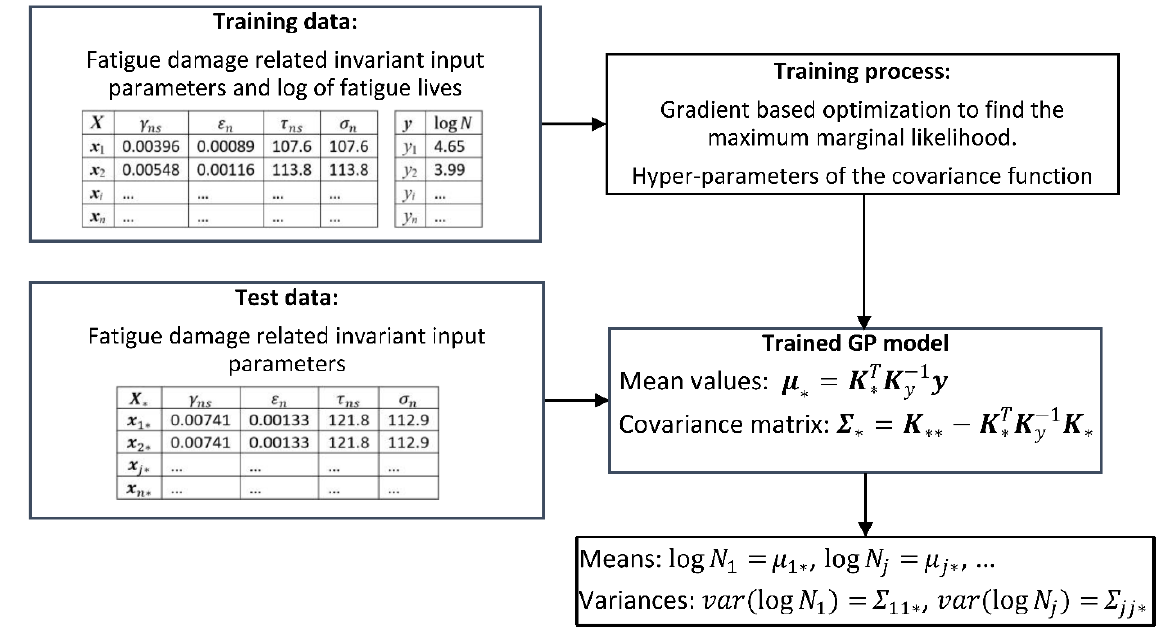
Figure A1. Diagram of data flow for the fatigue life prediction based on the proposed GP fatigue model.